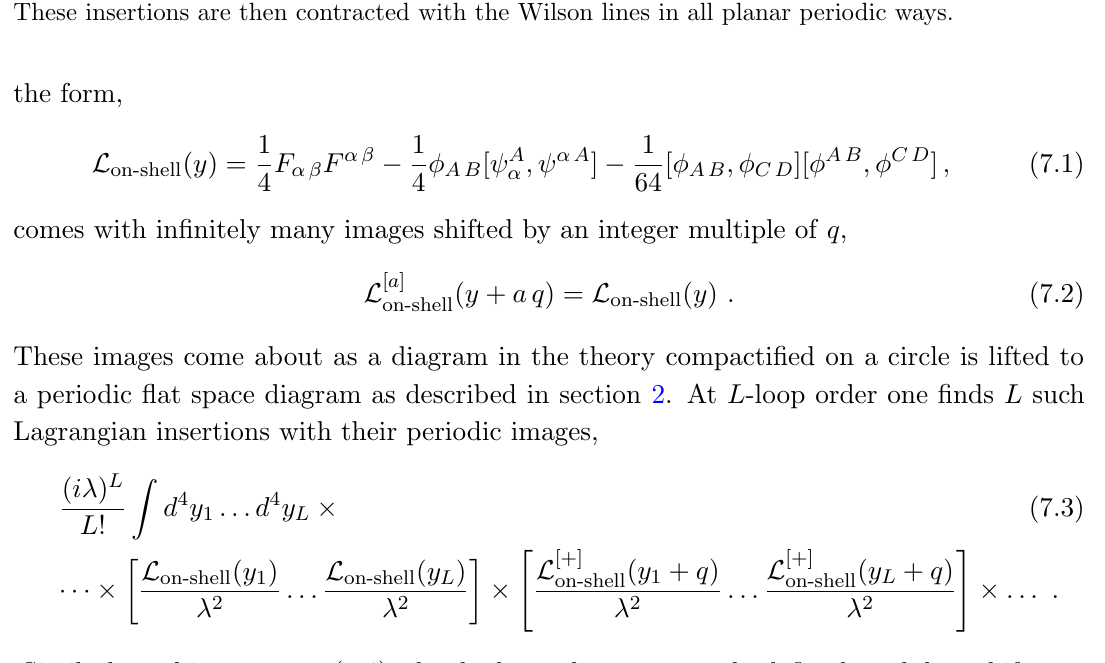
Figure 13 . The cylinder integrand of the cylinder Wilson lines correlator. At L loops there are L chiral Lagrangian insertions. Each lagrangian insertion has in(cid:12)nitely many images separated by q . These insertions are then contracted with the Wilson lines in all planar periodic